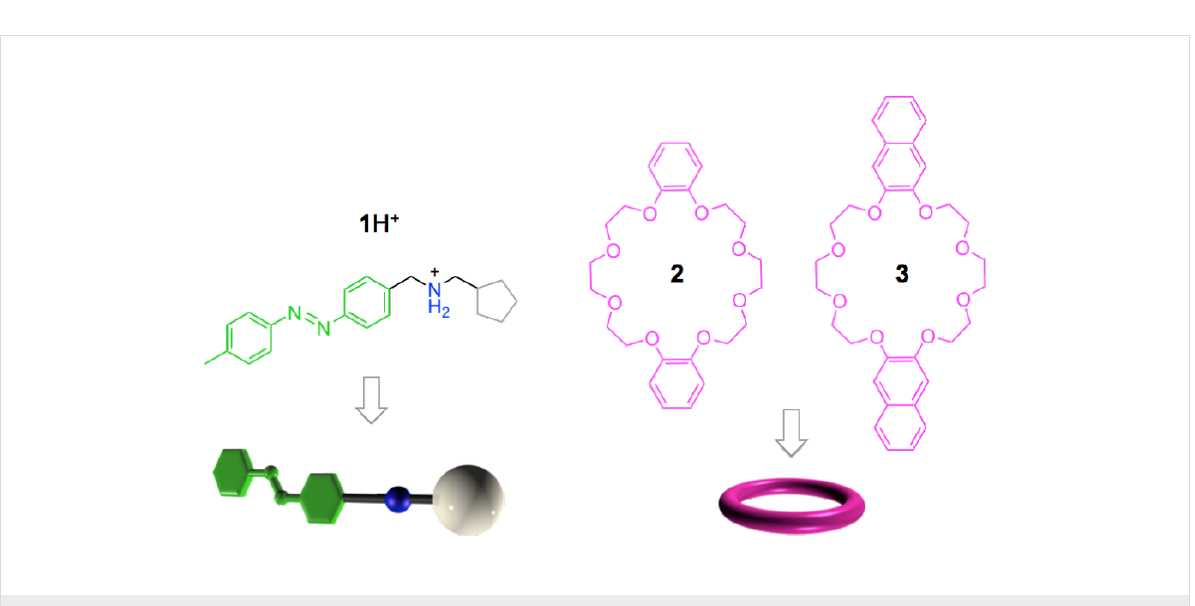
Figure 4: Structure formula and schematic representation of the examined molecular